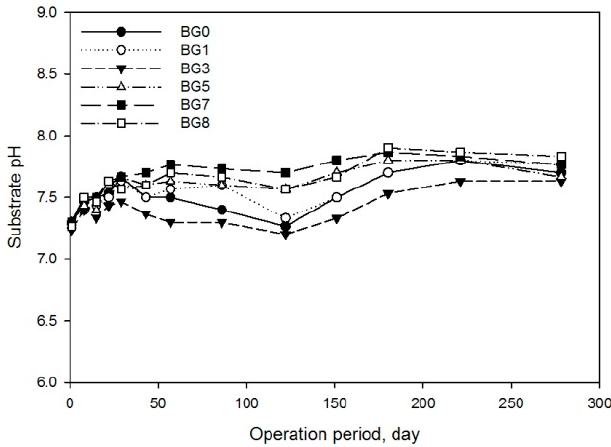
Figure 2. pH changes in the BMP treatments. Each point denotes the average of three replicates.